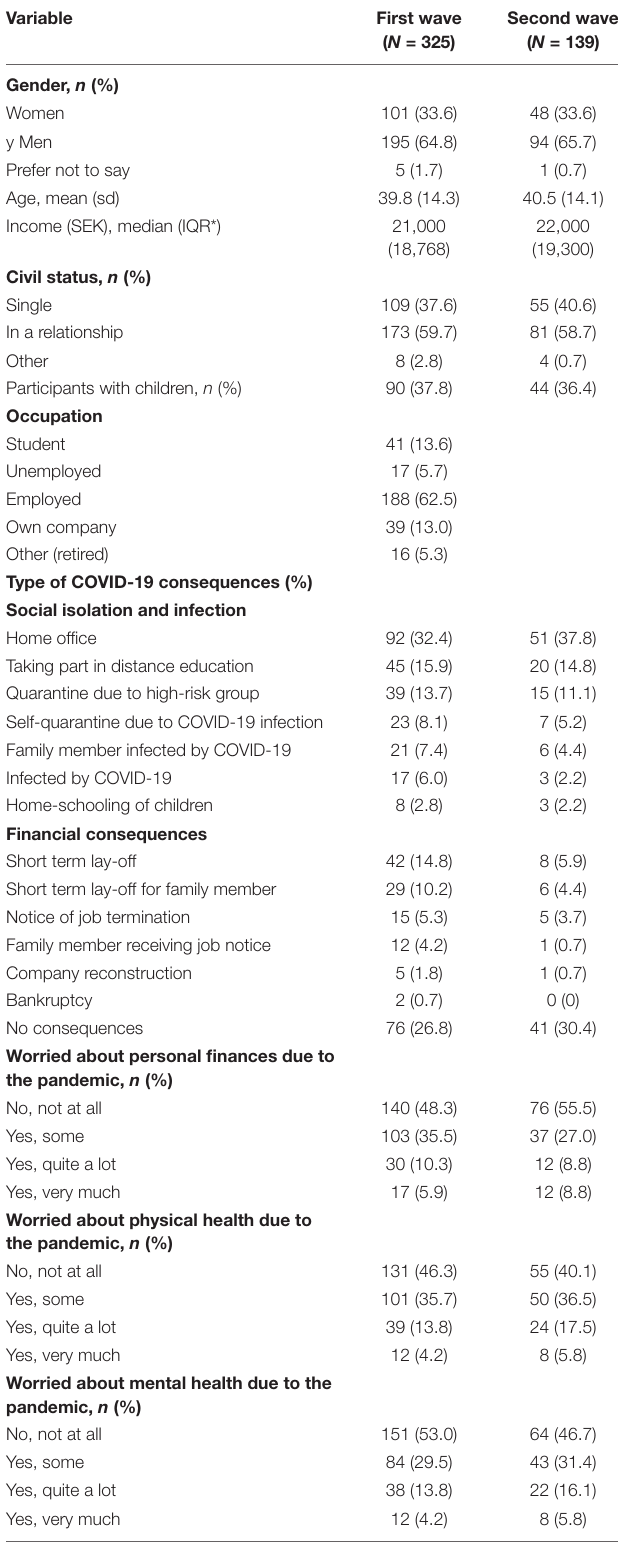
TABLE 1 | Sample characteristics and COVID-19 related variables for the first and second waves.